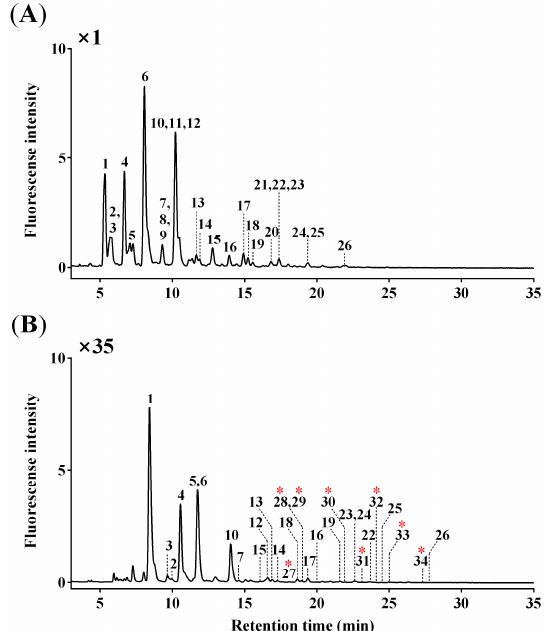
Figure 1. UPLC chromatograms of ( A ) AB-labeled (major and minor) O -glycans (Peaks 1–26) and ( B ) ProA-labeled (trace) O -glycans (Peaks 27–34; red asterisks) from BSM. Six peaks corresponding to 15 O -glycans co-eluted with others (Peak 2 with Peak 3, Peak 7 with Peaks 8 and 9, Peak 10 with Peaks 11 and 12, Peak 21 with Peaks 22 and 23, and Peak 24 with Peak 25 for AB-labeled O -glycans; Peak 28 with Peak 29 for ProA-labeled O -glycans). Structural